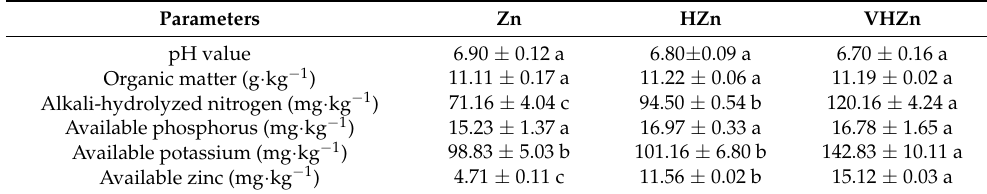
Table 1. Basic chemical properties of rice rhizosphere soil with different levels of Zn supply.